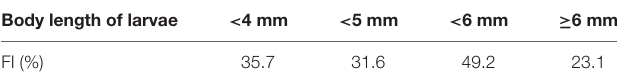
FIGURE 5 | Composition of Scomber japonicus (black) and S. australasicus (white) larvae in the mouth of Kagoshima Bay and the Osumi Strait from 2017 to 2019, identified using PCR-RFLP. KB and OS indicate the mouth of Kagoshima Bay and the Osumi Strait, respectively. Numbers indicate sample size. TABLE 2 | Ontogenetic variation in feeding intensity (FI) of Scomber japonicus larvae.